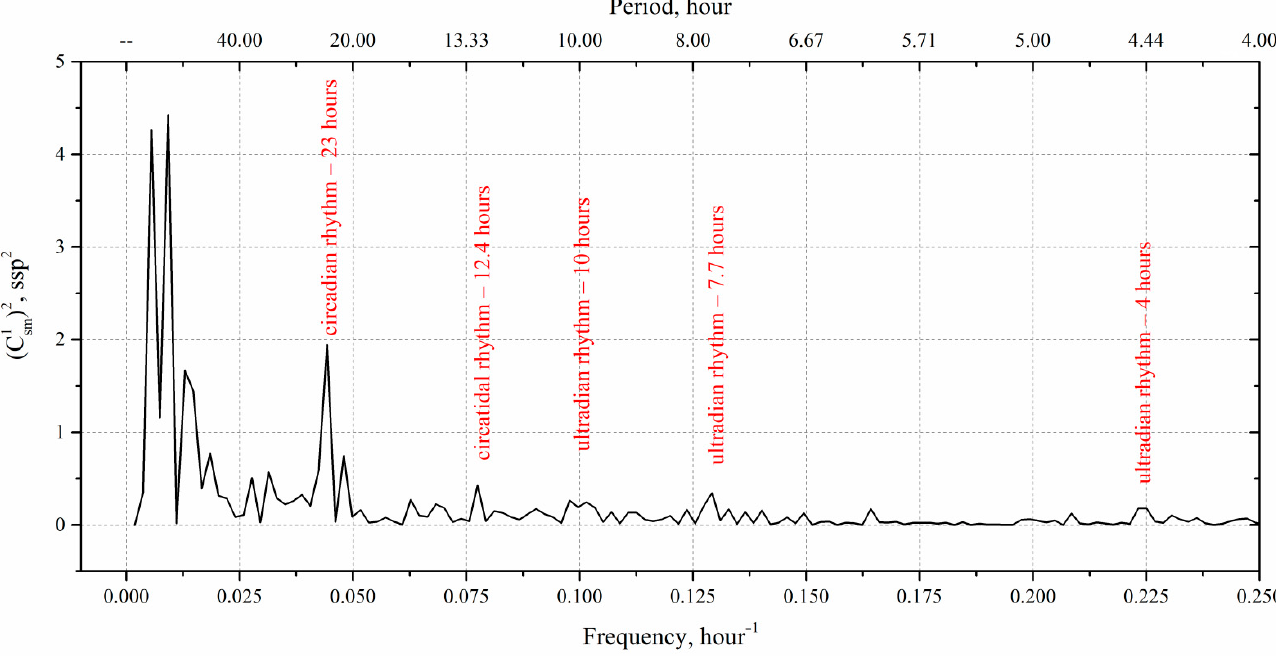
Figure 9. Spectrum structure of the time series of measurements. Black line—spectral density of the plankton number shown in Figure 7b, recalculated per 1 L of water.